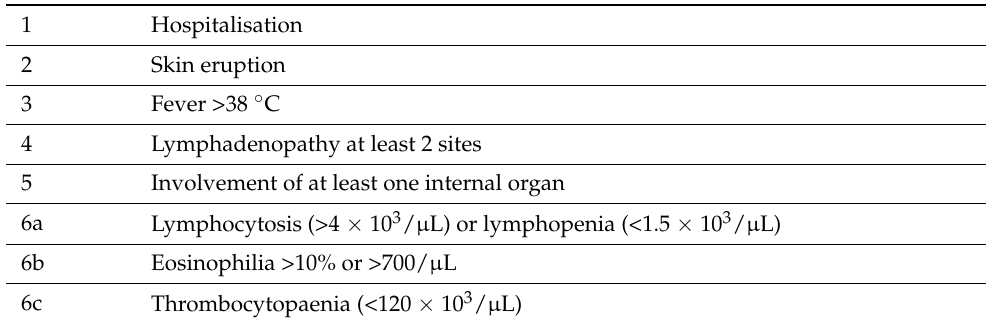
Table 1. RegiSCAR drug reaction with eosinophilia and systemic symptoms (DRESS) inclusion criteria *** [11].